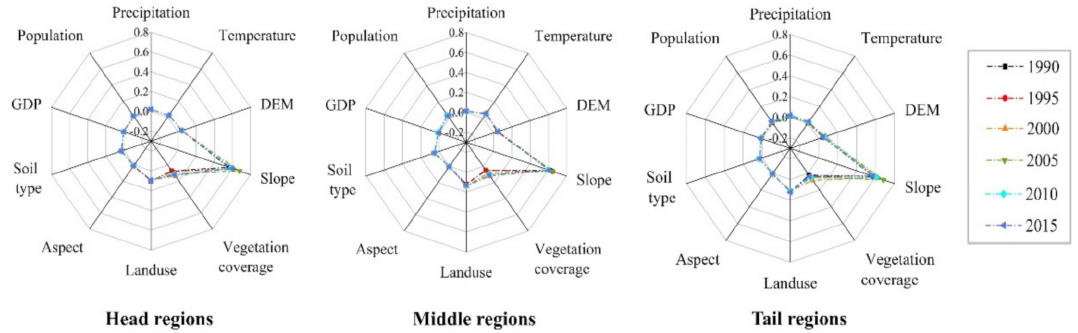
Figure 8. The q values of influencing factors in di ff erent regions of the TGRA from 1990 to 2015. In the middle region of the TGRA, the sequence of the factors was determined by slope, land use, and vegetation coverage. The slope still had the highest q value among the influencing factors, with an average explanatory power of 62.18% over the 25-year period. The explanatory power of land use reached an average q value of 13.29% over the 25-year period, which was notably larger than that in the head and tail regions. Vegetation coverage had an explanatory power of 8.73% over the 25-year period, which was slightly weaker than that in the head region of the TGRA.